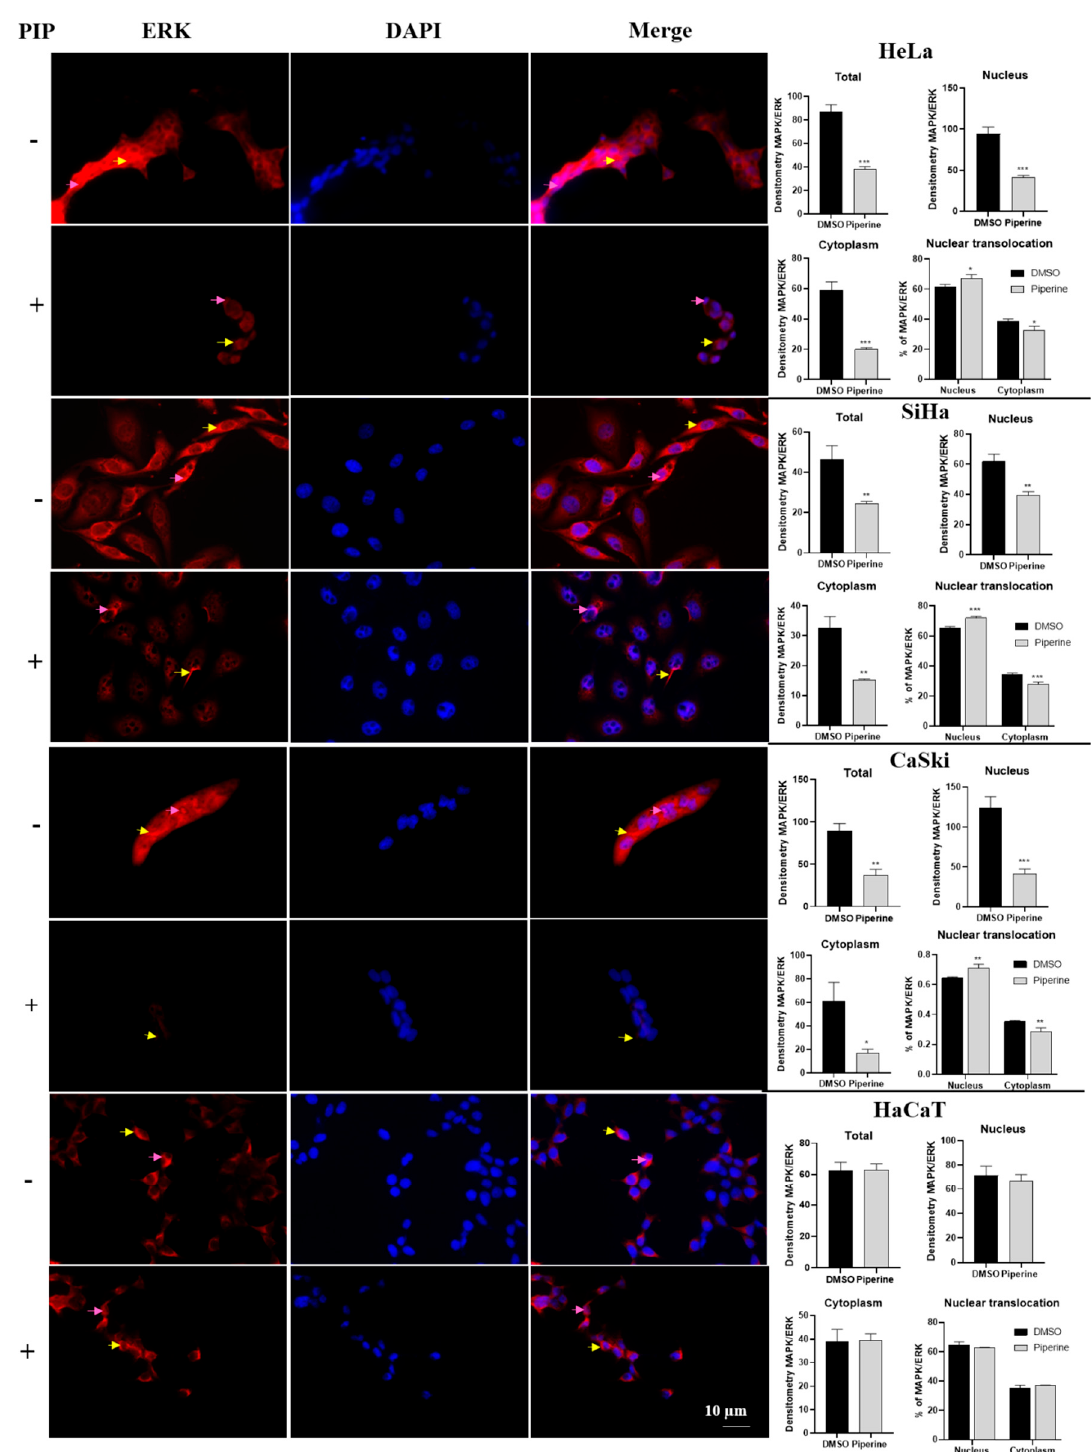
Figure 7. Immunocytochemistry of ERK/MAPK protein expression is indicated by a yellow arrow in the cytoplasm and pink arrow in the nucleus. Graphs showing densitometry in each cell and nuclear translocation compartment after treatment with control (DMSO) and piperine [150 µ M]. * vs. control, p < 0.05, ** vs. control, p < 0.01, *** vs. control, p <